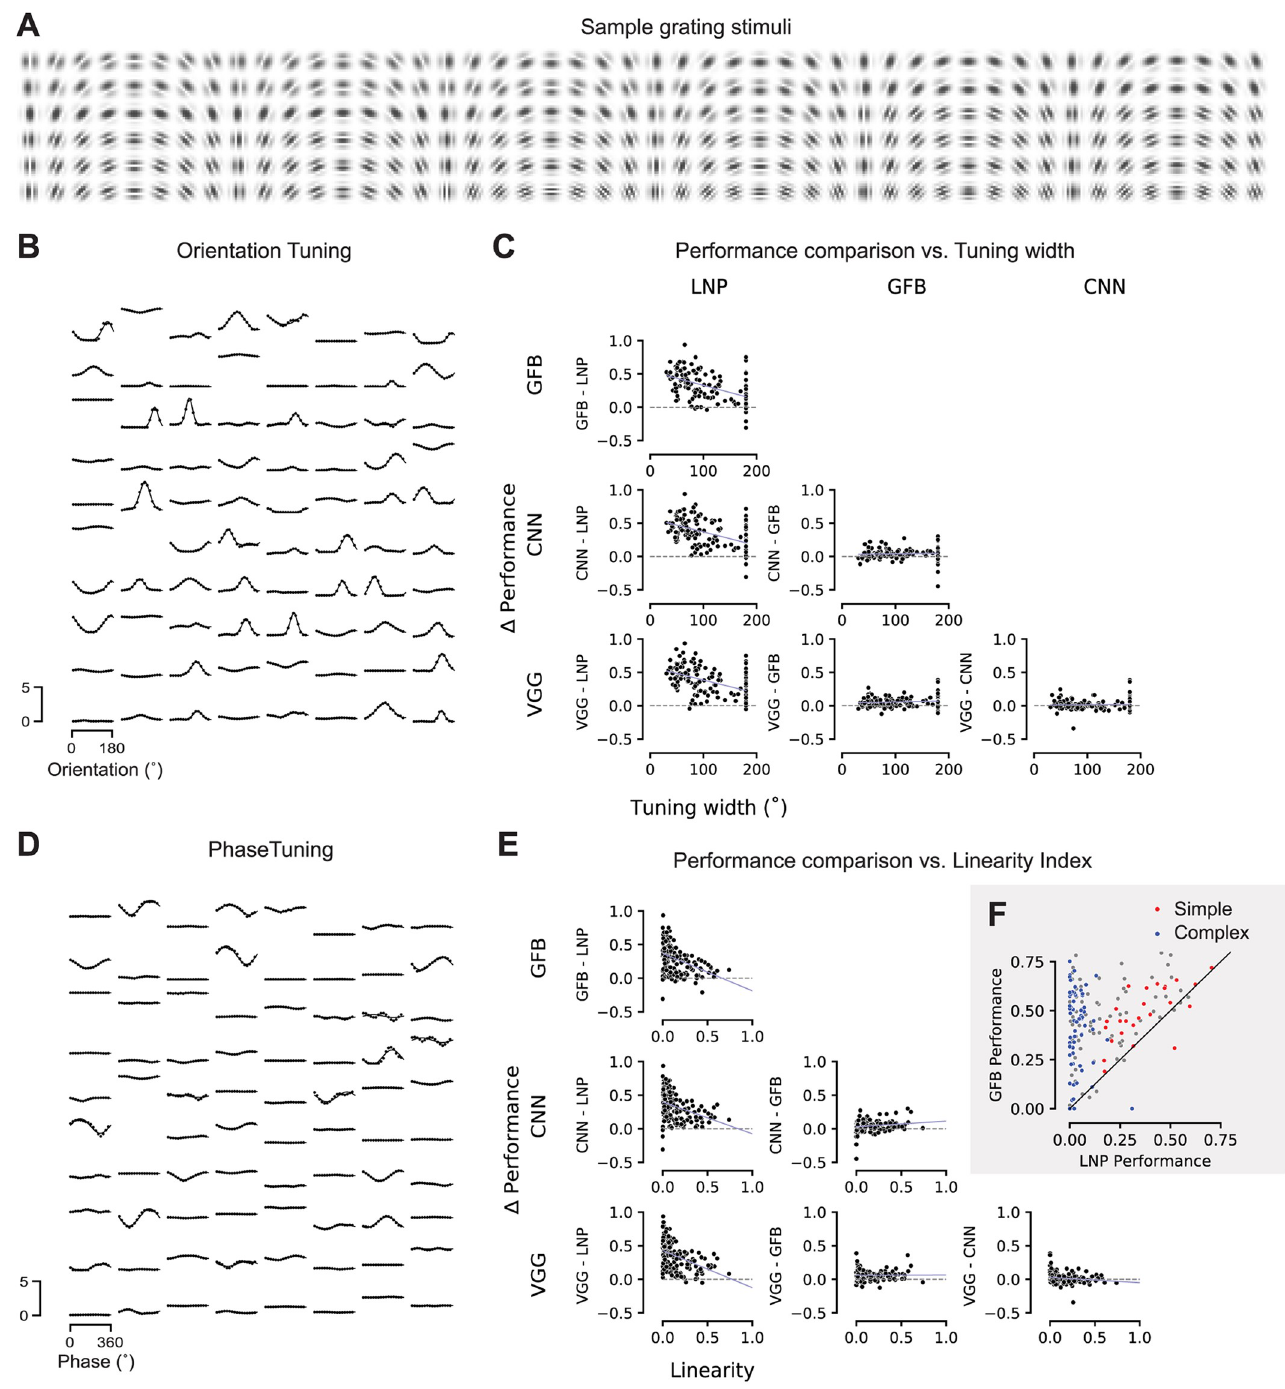
Fig 9. Relationship between model performance and neurons’ tuning properties. A . A sample subset of the Gabor stimuli with a rich diversity of frequencies, orientations, and phases. B . Dots: Orientation tuning curves of 80 sample neurons predicted by our CNN model. Tuning curves computed at the optimal spatial frequency and phase for each neuron. Lines: von Mises fits. C . Difference in performance between pairs of the four models as a function of tuning width. Tuning width was defined as the full width at half maximum of the fitted tuning curve. D . Dots: Phase tuning curves of the same 80 sample neurons as in B, predicted by our CNN model. Tuning curves computed at the optimal spatial frequency and orientation for each neuron. Lines: Cosine tuning curve with fitted amplitude and offset (see Methods). E . Like C, the difference in performance between pairs of models as a function of the neurons’ linearity index. Linearity index: ratio of amplitude of cosine over offset (0: complex; 1: simple). F . Performance comparison between GFB and LNP model. Red: simple cells (top 16% linearity, linearity > 0.3); blue: complex cells (bottom 28% linearity, linearity < 0.04).